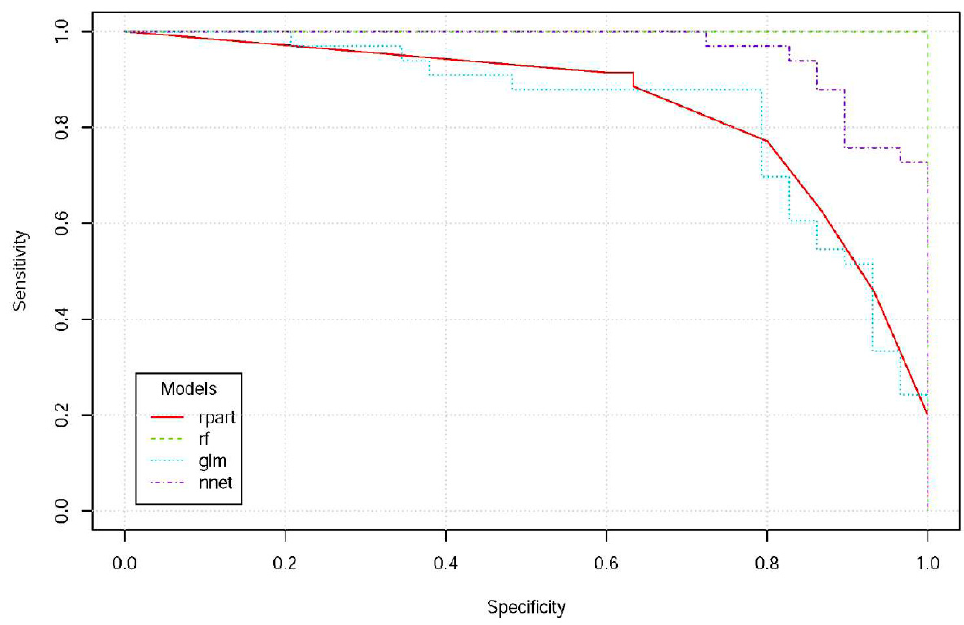
Figure 3. Heatmap of concentrations of exposure biomarkers (PAHs and BTEX in pleural fluid) in lung cancer patients and controls.